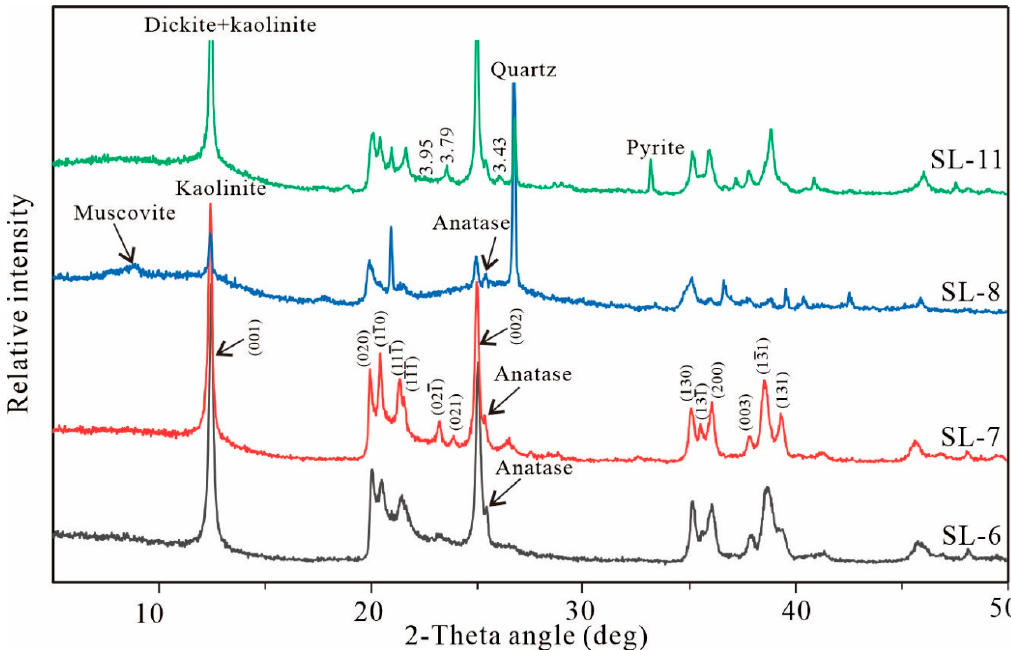
Figure 4. X-ray diffraction (XRD) patterns of minerals in selected samples.